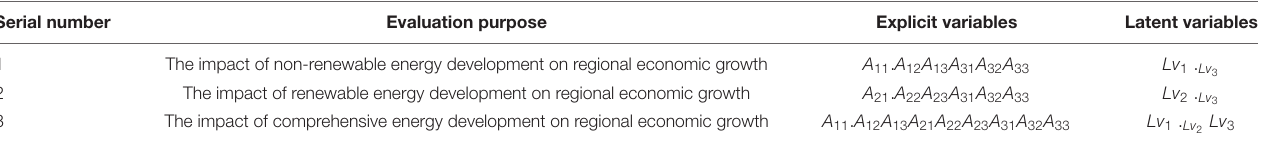
TABLE 2 | Evaluation objectives of energy development